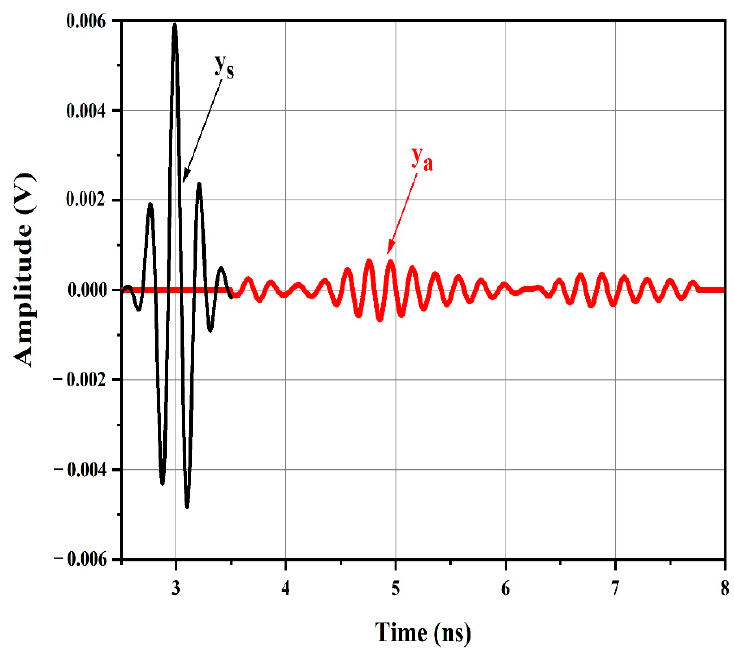
Figure 7. Magnified portion showing the structural mode ys(t) and antenna mode backscatter